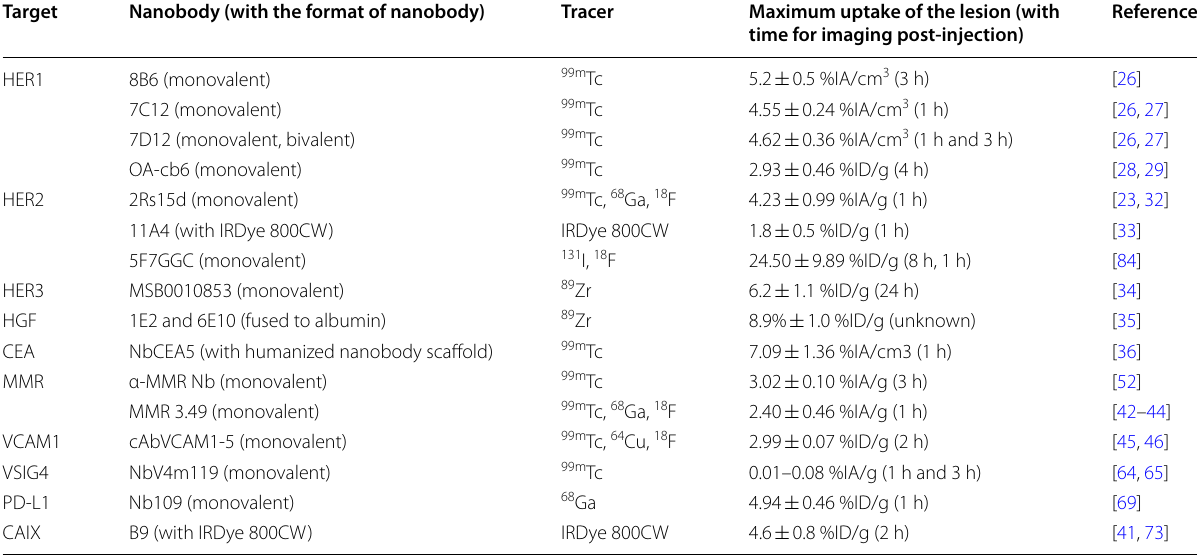
Table 1 Nanobodies for molecular imaging